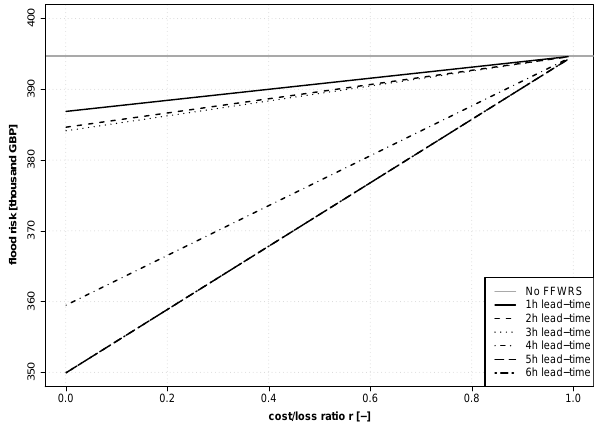
Fig. 5. Flood risk in the Perfect Forecasts case, as a function of cost-loss ratio and lead-times. This flood risk includes unavoidable flood damage and the cost of flood warning response.